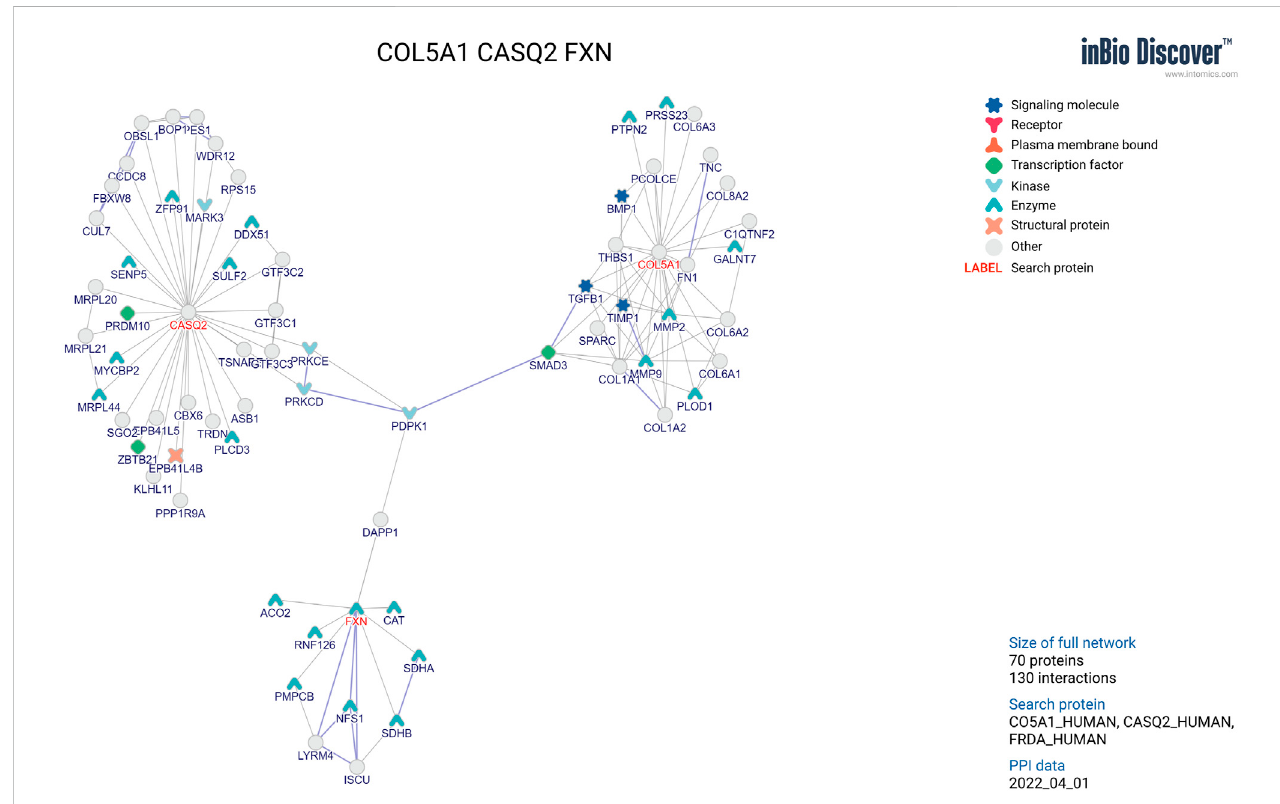
FIGURE 1 Functional gene network for the targeted genes from the present